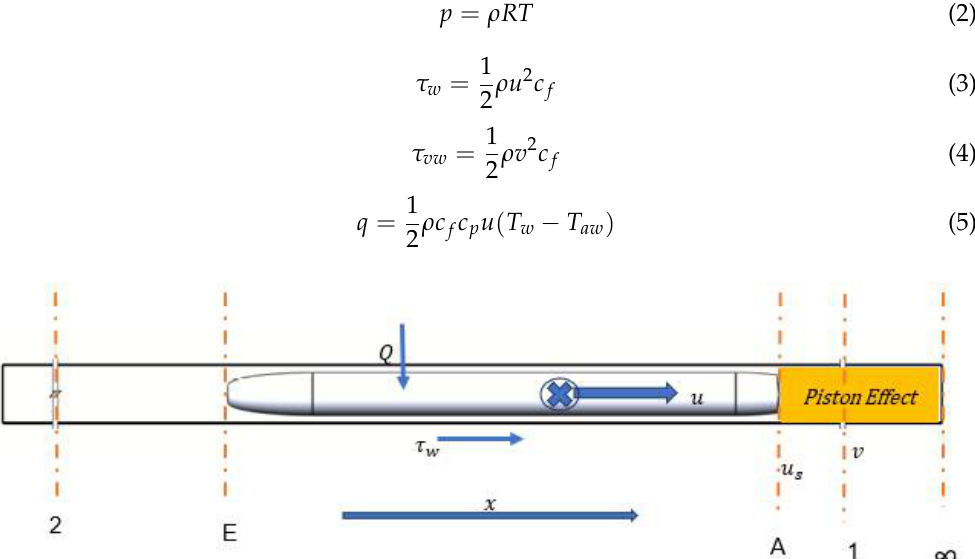
Figure 1. ( a ) Pod and cabin detailed views; ( b ) simplified 2-D pod configurations.